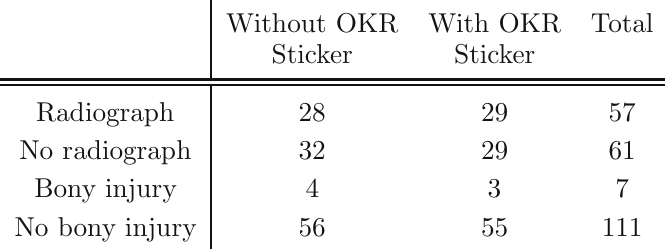
Table 2 Radiography requesting pattern and